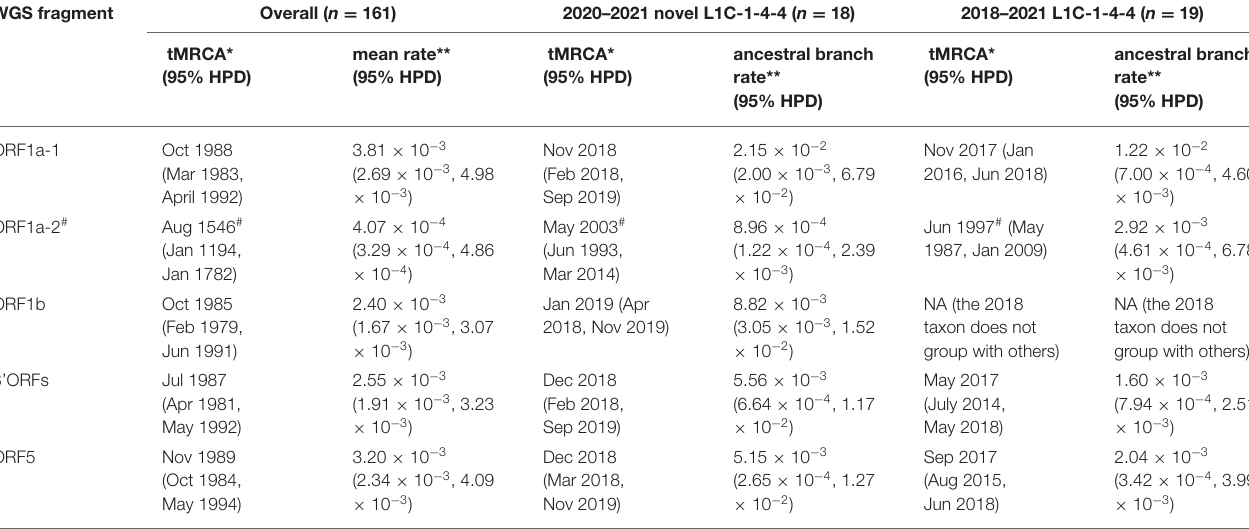
TABLE 1 | Ancestral date and evolutionary rate estimates of the novel L1C-1-4-4 variants and other PRRSV-2. WGS